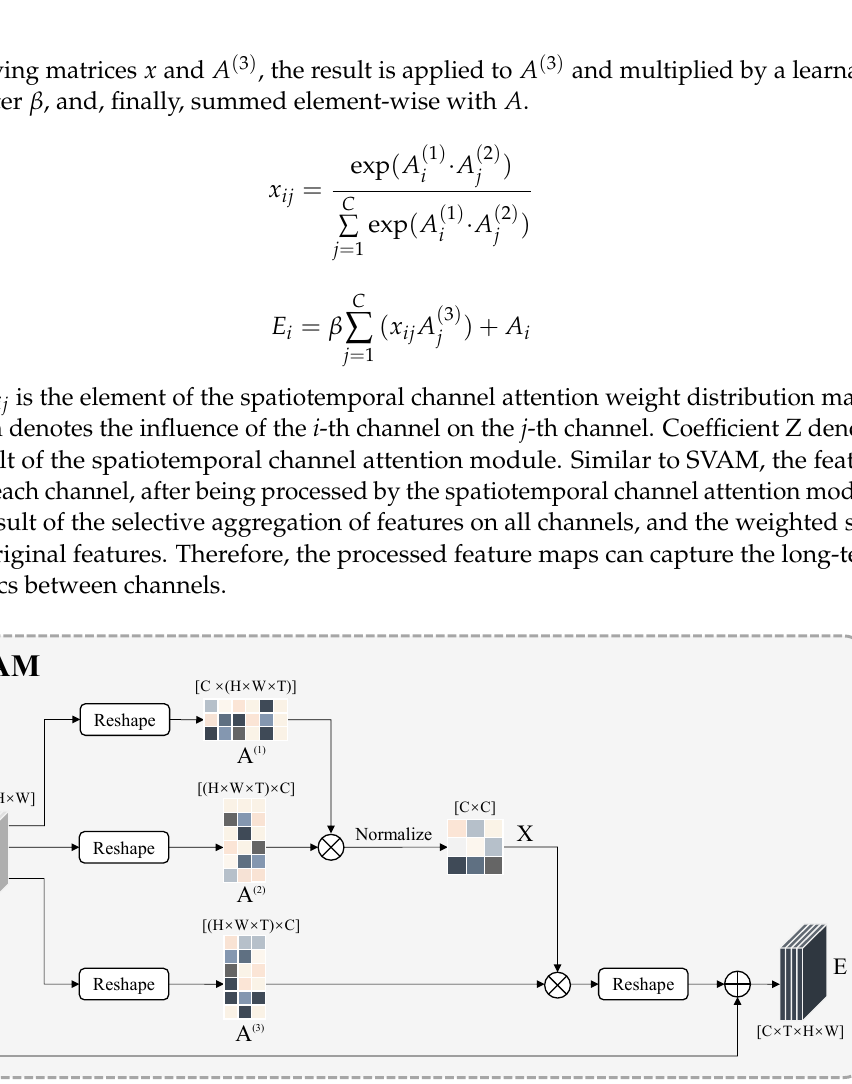
Figure 4. Architecture of SCAM. SCAM takes the feature extracted by I3D as input, which is designed for capturing the dependence between channels in the spatiotemporal domain. A ( 1 ) , A ( 2 ) , A ( 3 ) correspond to query, key, and value matrices in the attention mechanism. The output feature of each channel is the result of the selective aggregation of features on all channels, and the weighted sum of the input features.